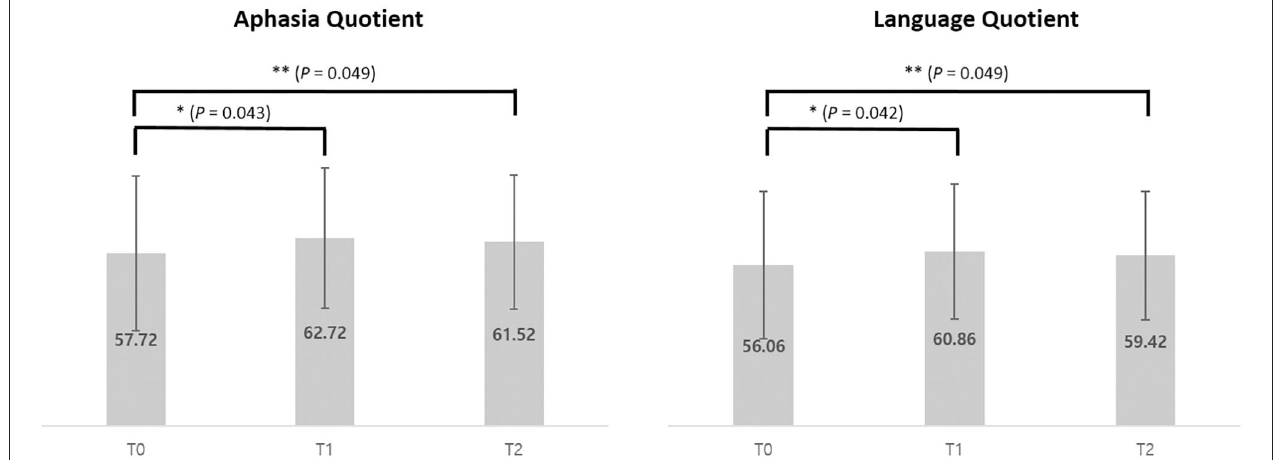
FIGURE 4 | Average of Aphasia Quotient and Language Quotient scores of pre (T0), post (T1), and 1 month after (T2) intervention of 5 participants. * p < 0.05 (using Wilcoxon signed-rank test). ** p < 0.05 (using Friedman test).